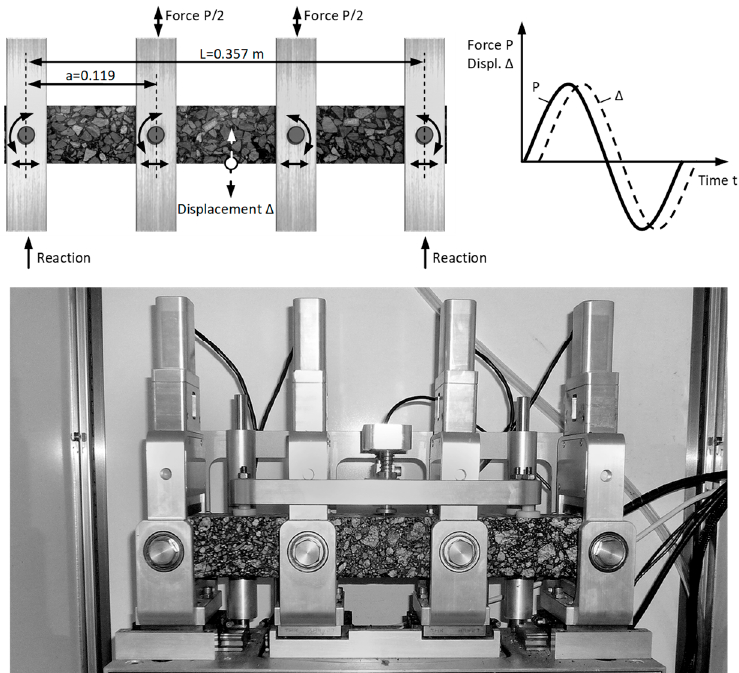
Figure 5. The scheme of the dynamic 4BP test.